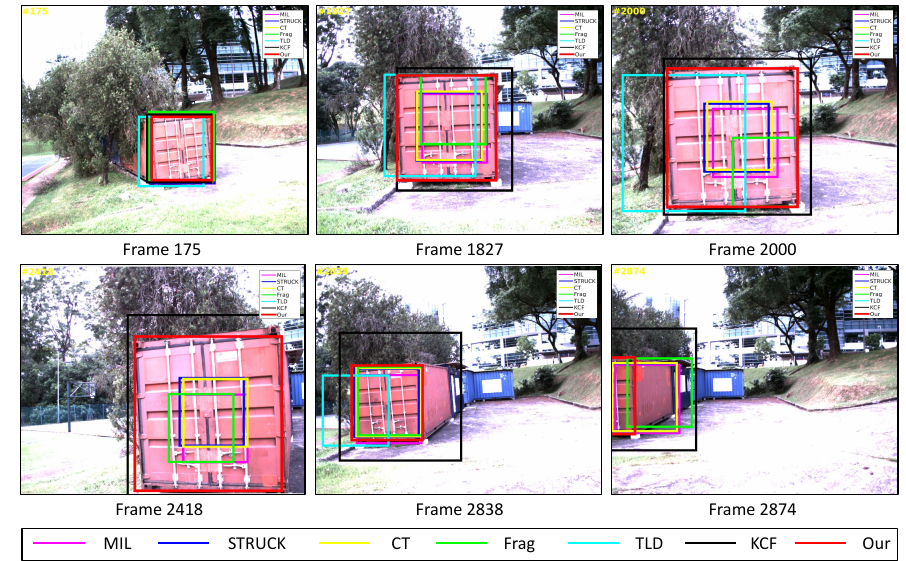
Figure 18. Some tracking results in the container image sequence. The total number of frames: